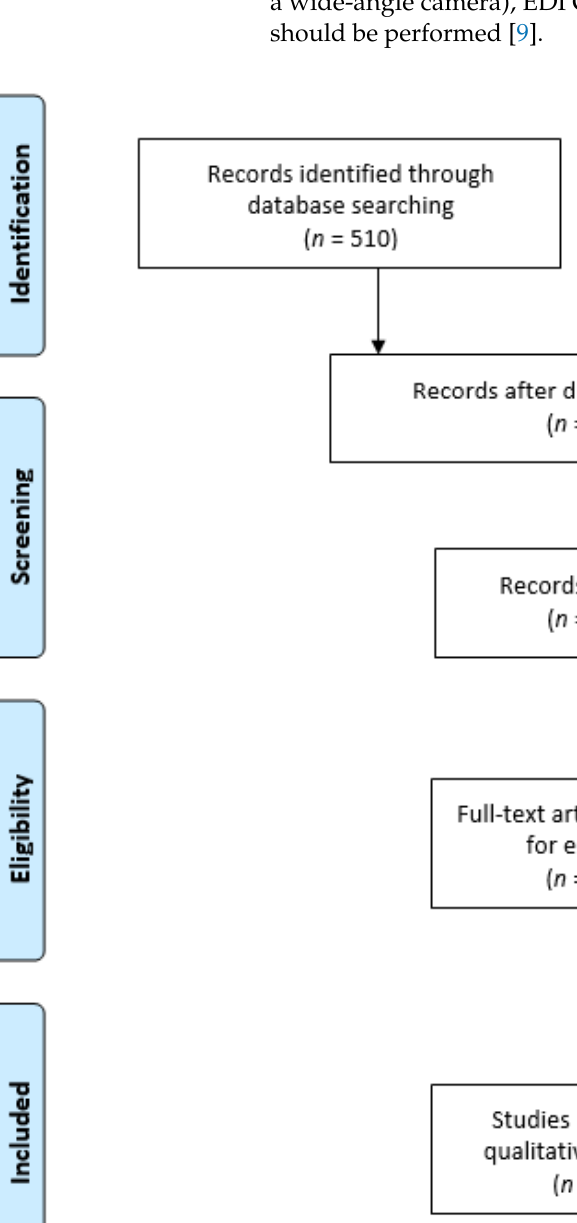
Figure 1. Preferred reporting items for systematic reviews and meta-analyses (PRISMA 2009) flowchart [14] .